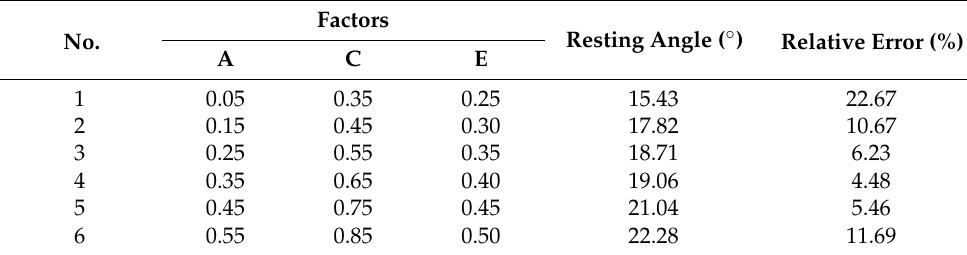
Table 5. Scheme and results of steepest ascent test.